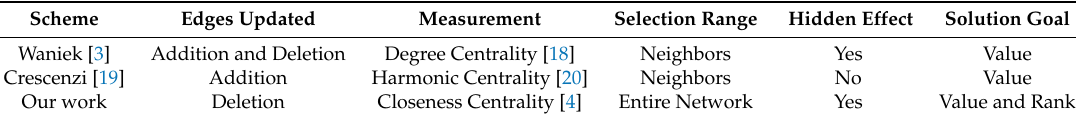
Table 1. Comparison with related